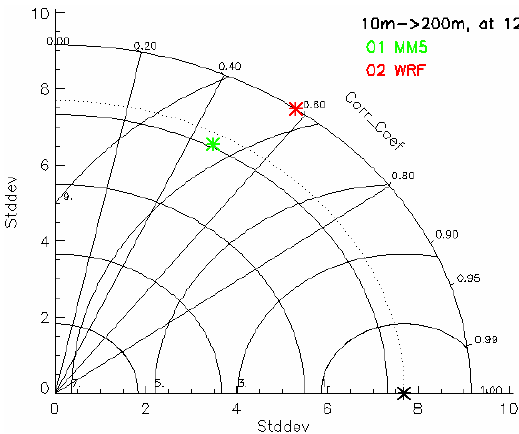
Fig. 3d. Statistics (Taylor plot, Taylor, 2001) for vertical potential temperature gradient profiles (10m–200m) by WRF, MM5 for the Linate airport, together with the observations for 12:00h for the whole year.